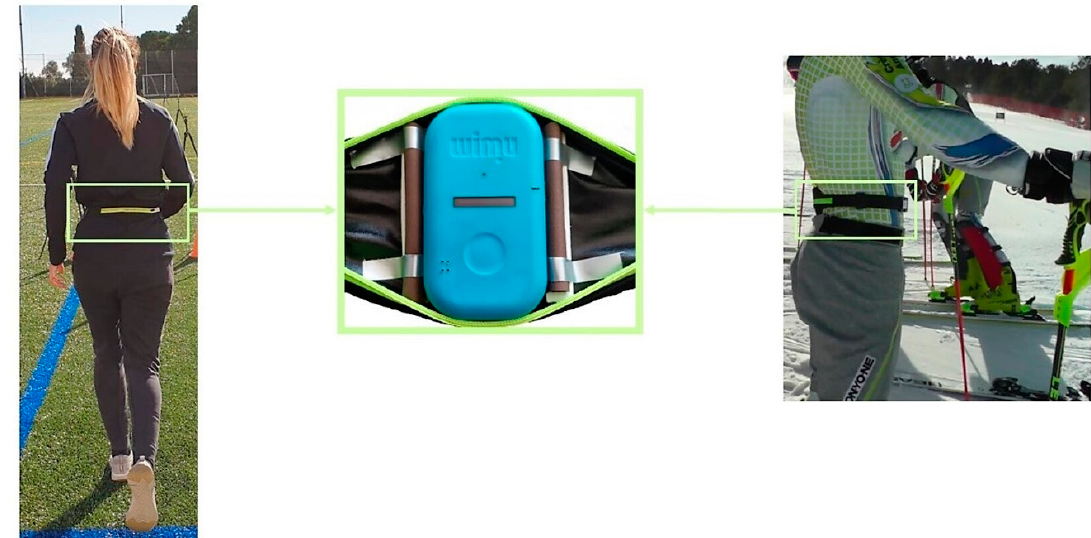
Figure 2. IMU device fixed on the athlete/skier’s lower back, at the L4–L5 level using an adjustable sports lycra